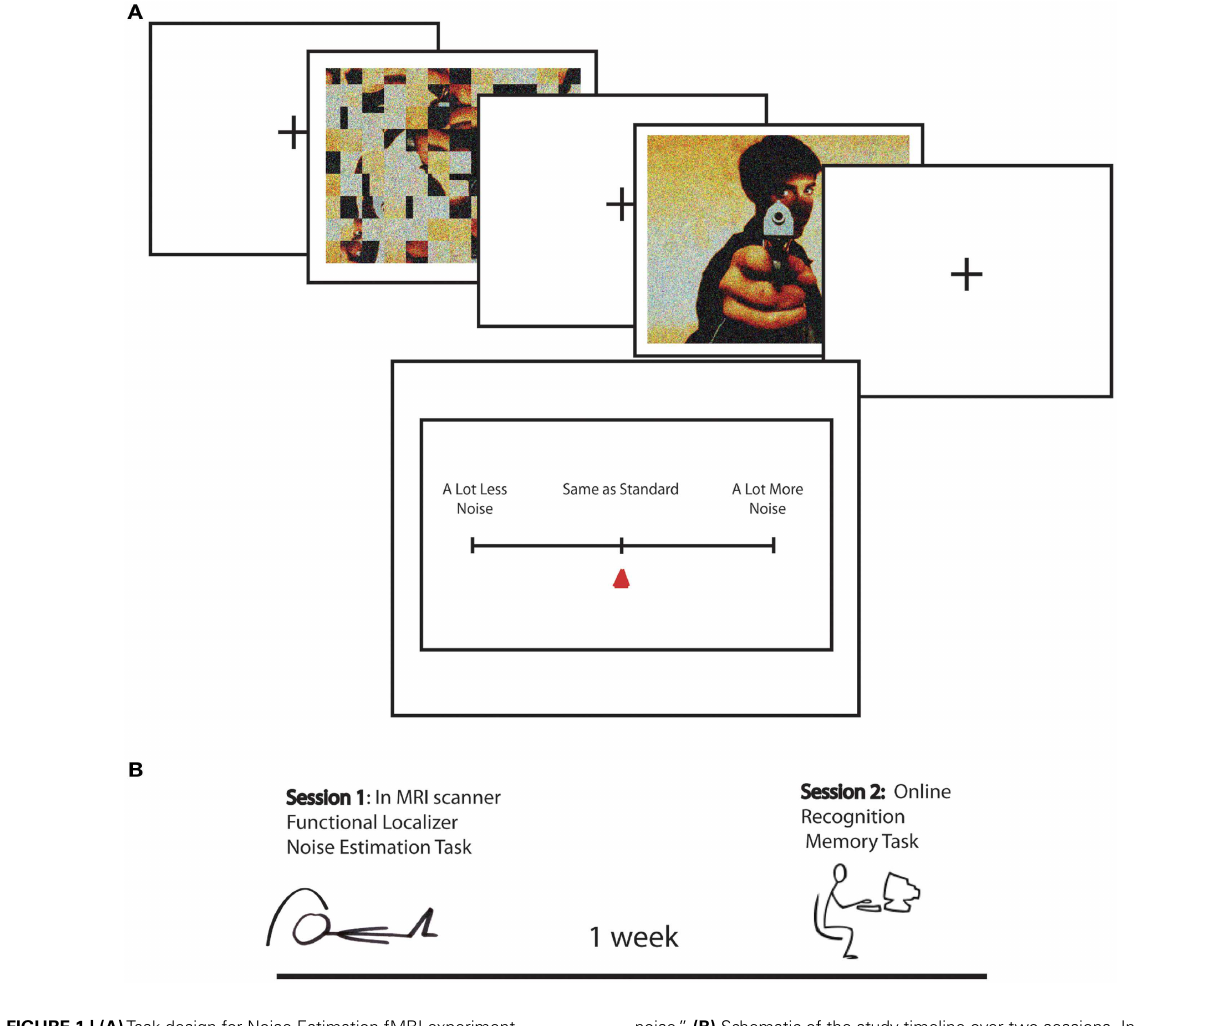
noise.” (B) Schematic of the study timeline over two sessions. In Session 1 participants performed the Noise Estimation task in the scanner. One week later they performed an online recognition memory task in which they were asked if images were old or new, and if they were old how vividly they were remembered on a scale from vague to